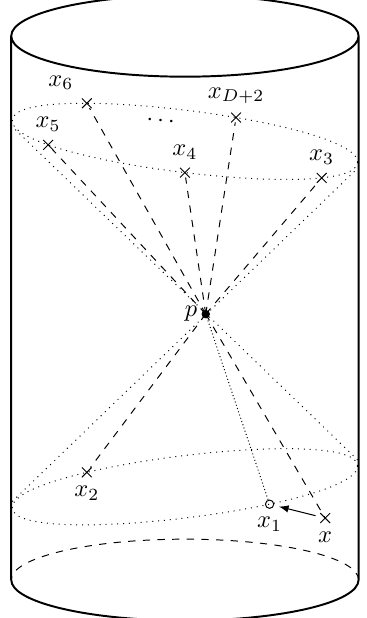
Figure 6 . Con(cid:12)guration of boundary points in the correlator (4.14) used to obtain the extended light-cone cuts from the dual (cid:12)eld theory. By choosing suitable operators at x and looking at the coe(cid:14)cient of the divergence when x approaches the cut point x 1 (cid:8) from regular cut points to the S k